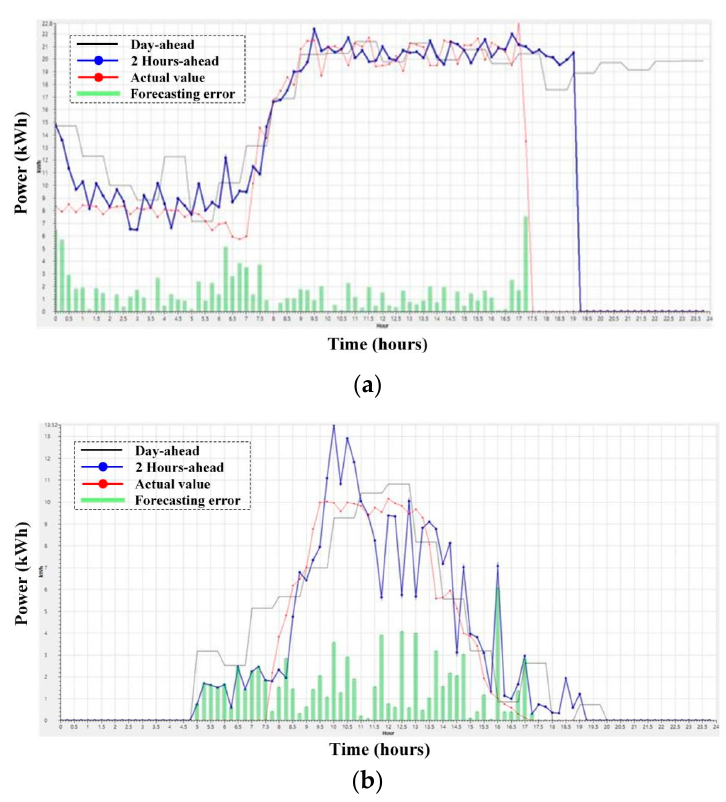
Figure 5. HMI screens of the forecasted and actual profiles before and during a typical winter day ( a ) load; ( b ) PV generation.